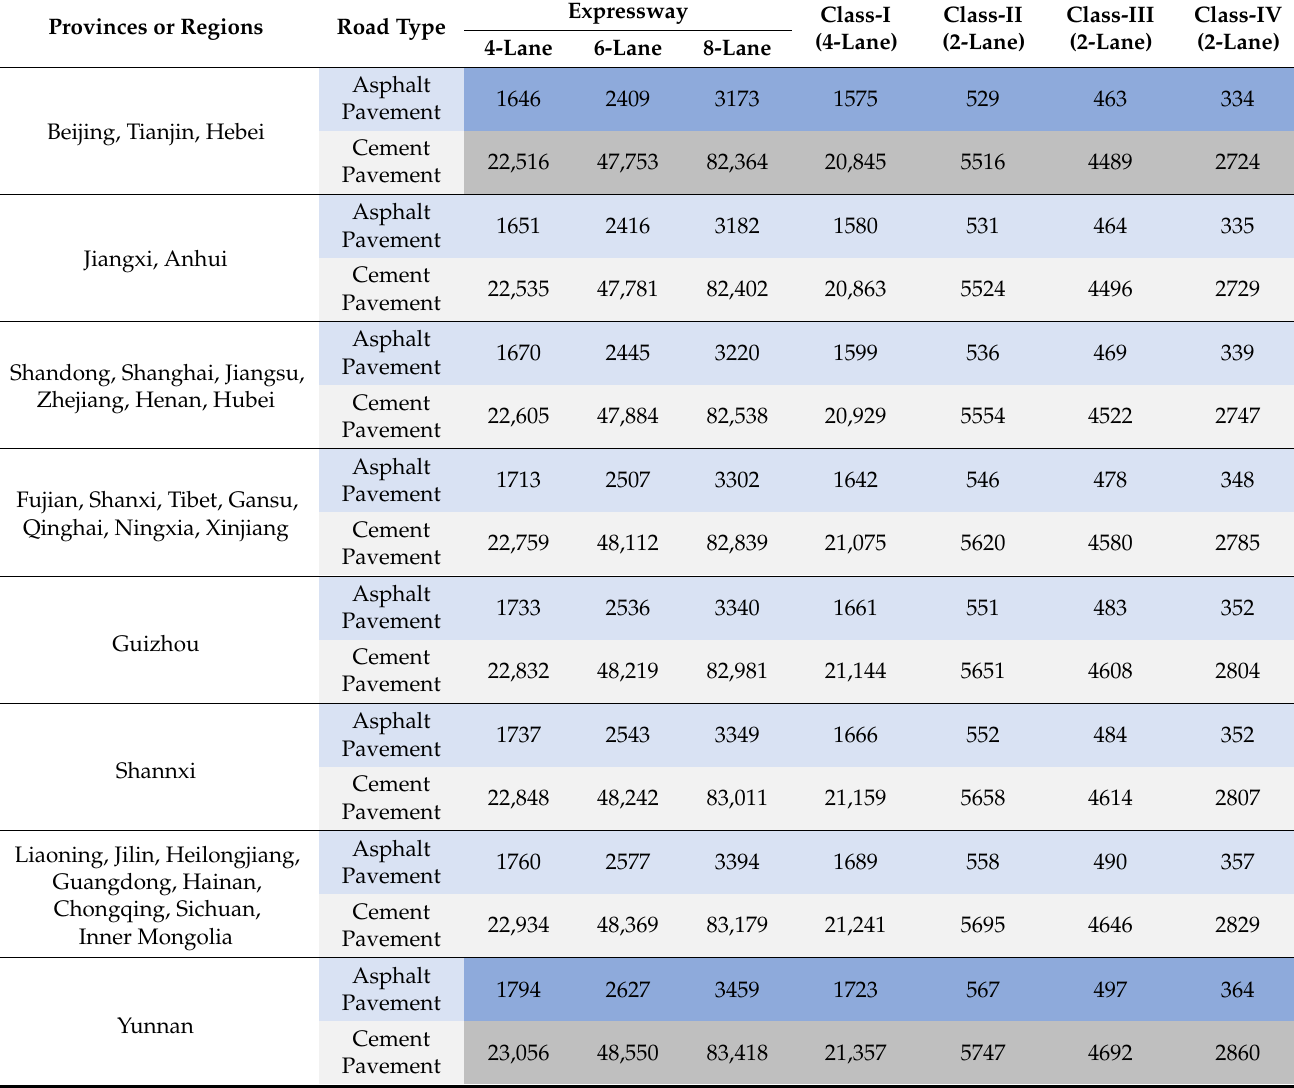
Table 3. Carbon emission factors of each road structure during construction phase (Blue background for asphalt pavement and grey background for cement pavement; units: